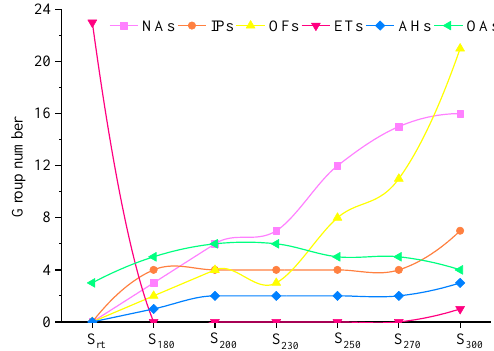
Figure 8. Group component numbers in S rt and S 180 – S 300 .